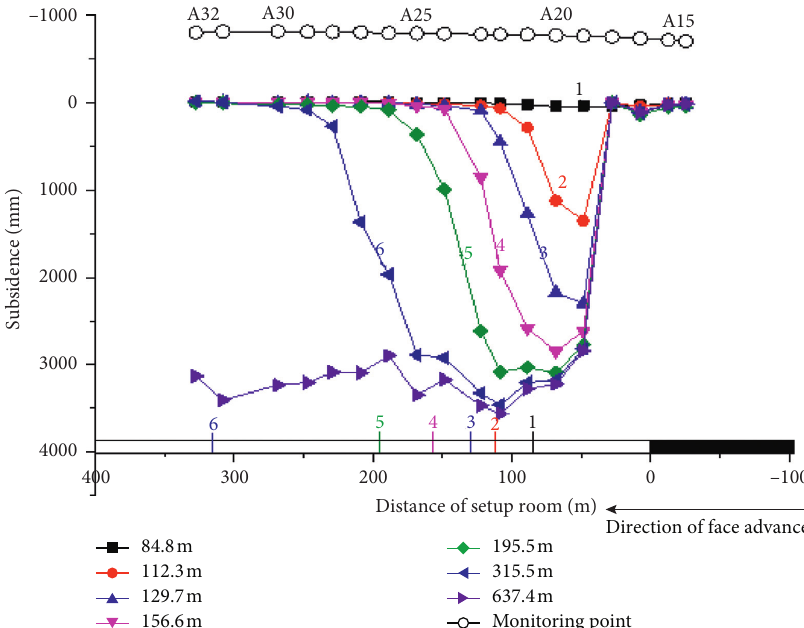
Figure 9: Subsidence curves.